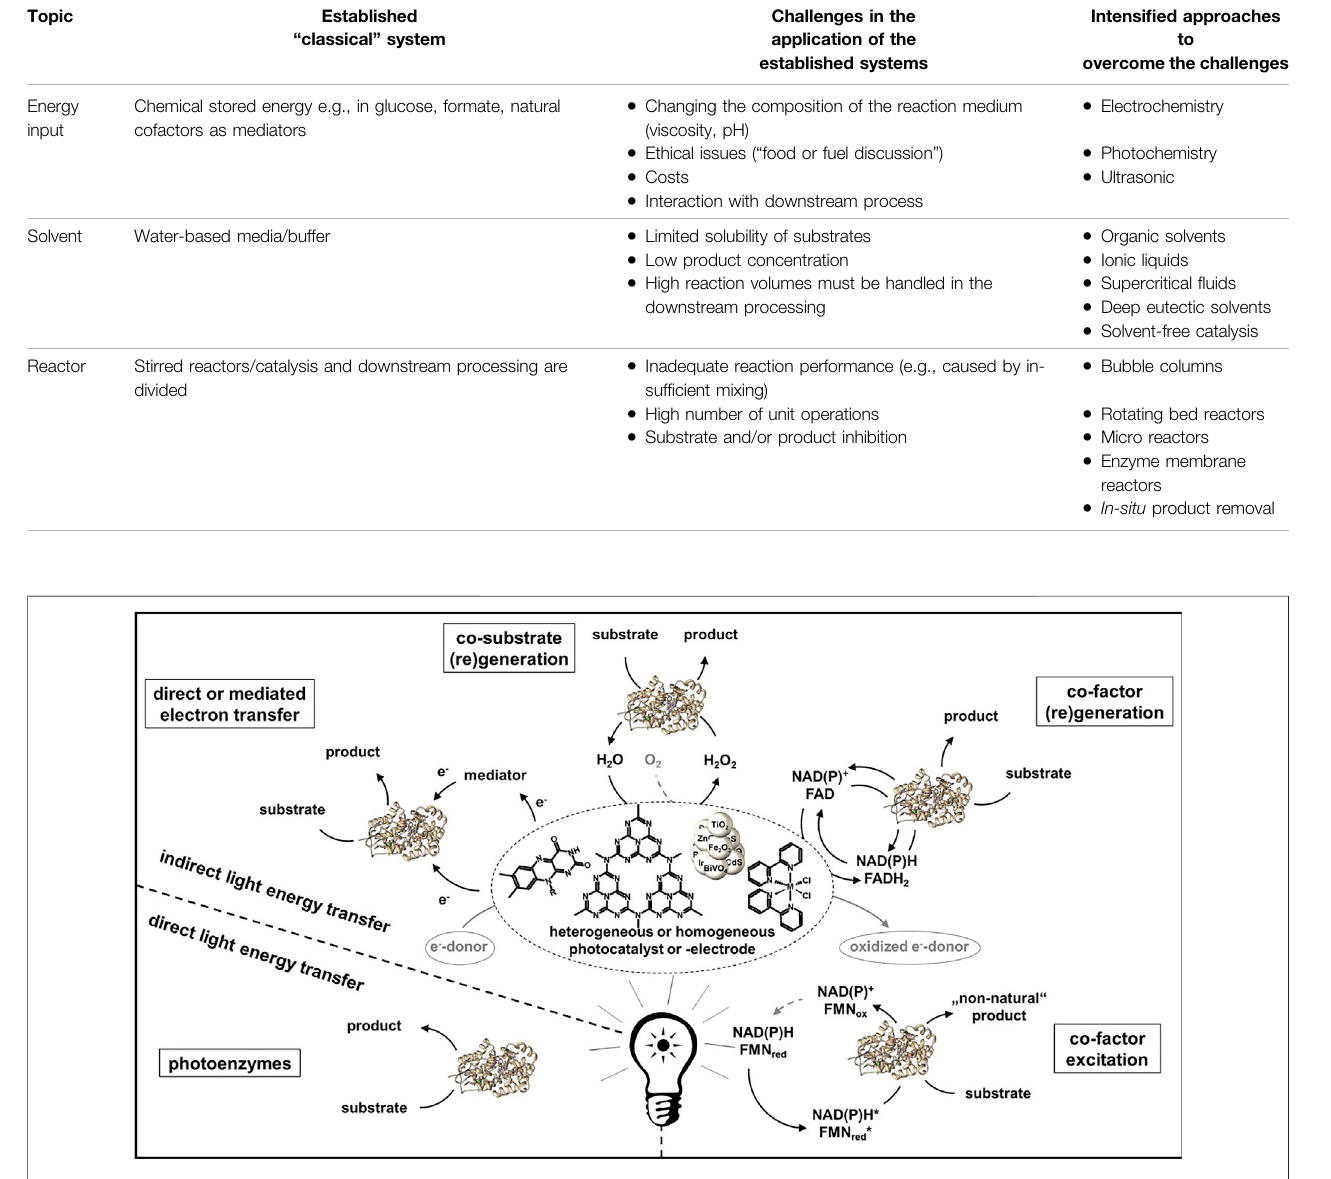
FIGURE 2 | Overview of photoenzymatic systems ordered by type of energy transfer from light to the enzyme.